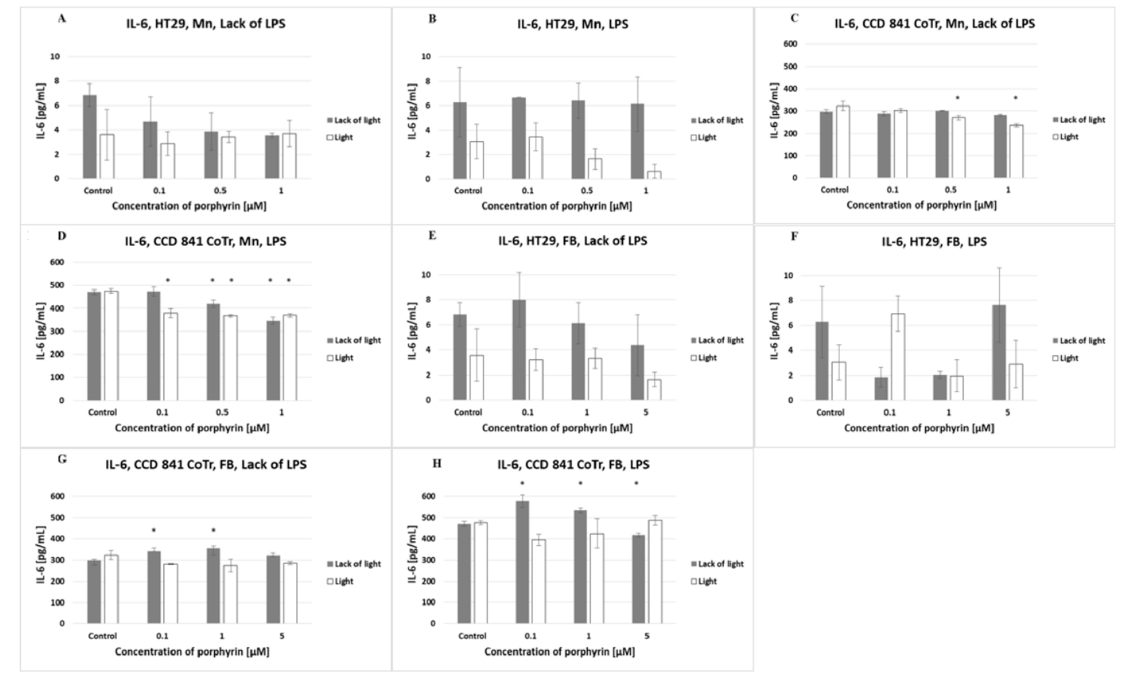
Figure 7. IL-6 secretion at the HT29 cell line (A, B, E, F) and culture of CCD 841 CoTr cells (C, D, G, H) over 24 h of incubation with manganese (Mn) (A-D) and free-base (FB) (E-H) porphyrins. ELISA test. Cells treated with porphyrin compared with a non-treated control culture. Cells treated with porphyrin compared with cells treated with porphyrin after pre-incubation with LPS. Columns and bars show the mean ± standard deviation ( n = 3). * - Statistical significance was analyzed at p < 0.05.